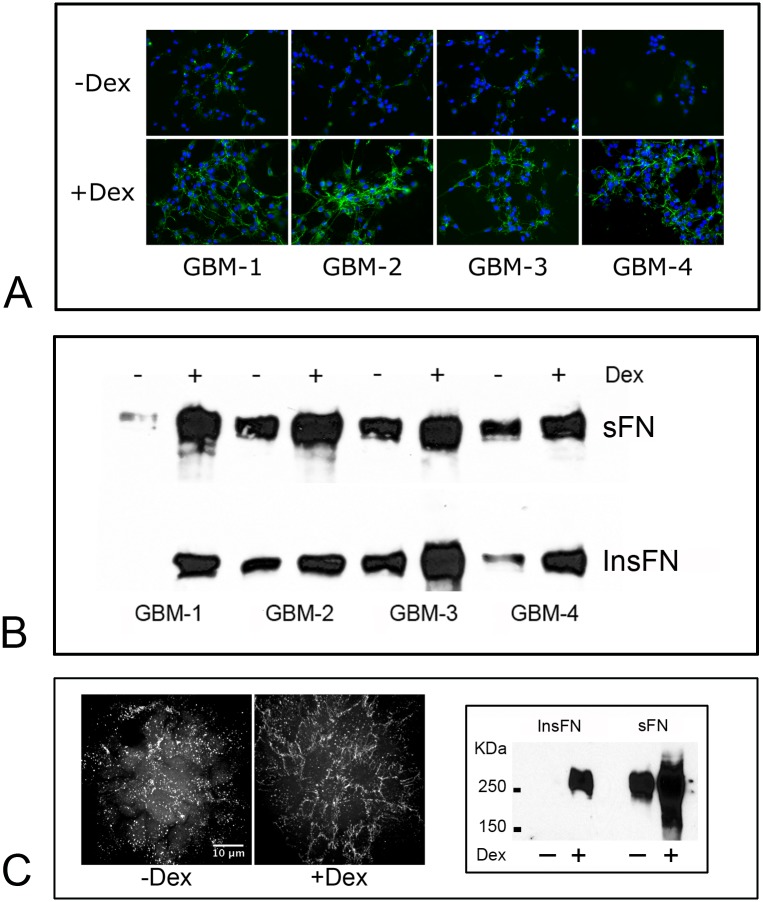

(A) Dex treatment activates FNMA in GBM cells. Immunofluorescence was used to compare FNMA in untreated and Dex treated GBM cells. Dex was added to a final concentration of 1x10−7M. Cells were treated for 24 hours prior to fixation. Dex treatment significantly increased FNMA in all lines. (B) Dex-mediated upregulation of FNMA was confirmed by immunoblot analysis. Lysates of untreated and Dex-treated cells were prepared by DOC differential solubilization and soluble (sFN) and insoluble (InsFN) fractions of FN were separated by SDS-PAGE. Note the increase in both soluble and insoluble fibronectins in response to Dex treatment. (C) 3D spheroids of GBM-3 were generated in the presence or absence of Dex and 50 μg/ml Rhodamine-conjugated FN. Dex treatment resulted in a marked re-organization of FN from punctate to fibrous (left panel). FNMA by spheroids was also assessed by DOC/SDS-PAGE and immunoblot analysis. Note the presence of insoluble fibronectin in response to Dex treatment (right panel).